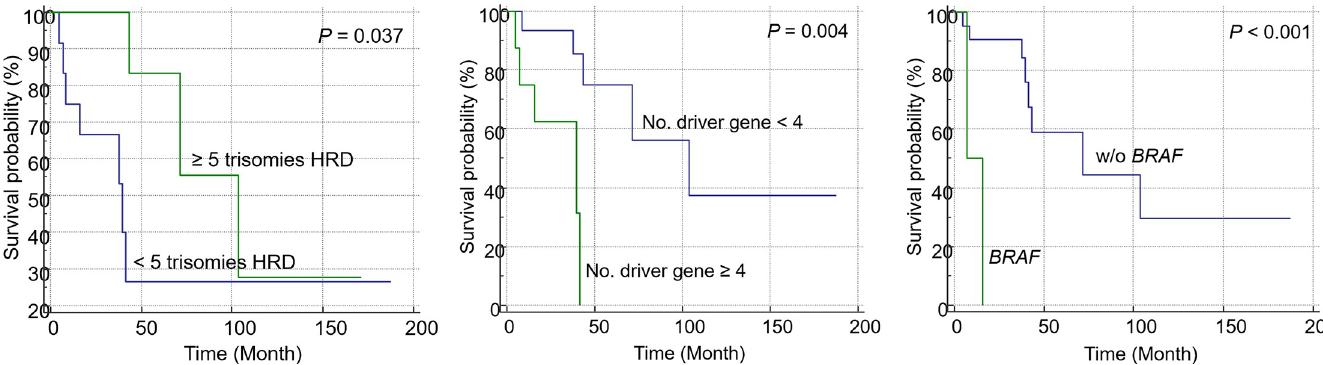
Fig 8. Kaplan-Meier curves showing the overall survival of patients with hyperdiploid Multiple Myeloma (MM). Patients with hyperdiploid MM were subdivided based on the (A) number of trisomies ( � 5 vs. < 5) ( P = 0.037), (B) number of mutated driver genes ( � 3 vs. < 3) ( P < 0.001), and (C) the presence of BRAF mutation ( P <